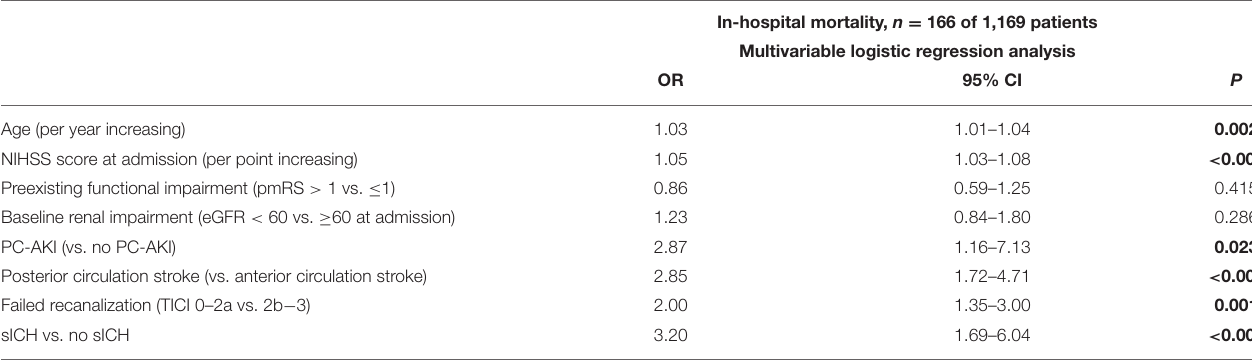
TABLE 2 | Multivariable logistic regression analysis for in-hospital